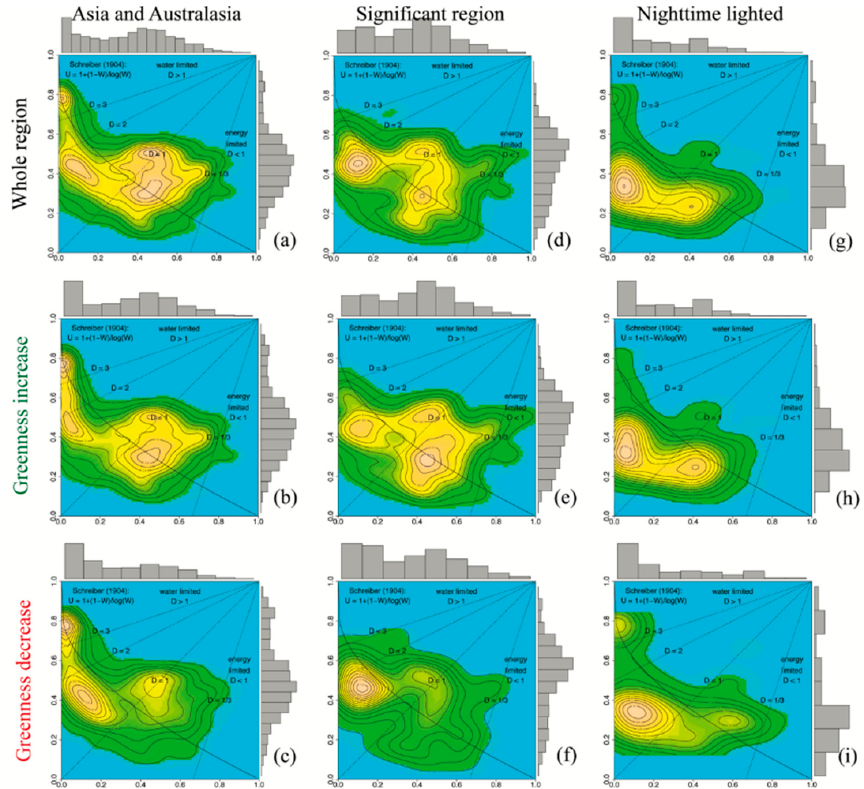
Figure 2. Frequency distributions of 34 year climate means in ( U,W ) state space spanned by relative excess energy (sensible heat flux vs. net radiation) and excess water (runoff vs. precipitation) in Asia and Australasia: ( a – c ) ( U,W ) climate means, ( d – f ) significant ( U,W ) change exceeding the standard deviations std( U ) or std( W ) from the climate means, and ( g – i ) ( U,W ) climate means of urbanized land surface only (that is, spatially contiguous lighted areas with DN ≥ 12 being classified as urbanized or cities; for detailed descriptions of data quality control and threshold selection, see text). The land surface states (upper row) are subdivided into the two categories of vegetation greenness increase or decrease from the first to the second period (middle and bottom row, 1982–1998 versus 1999–2015).